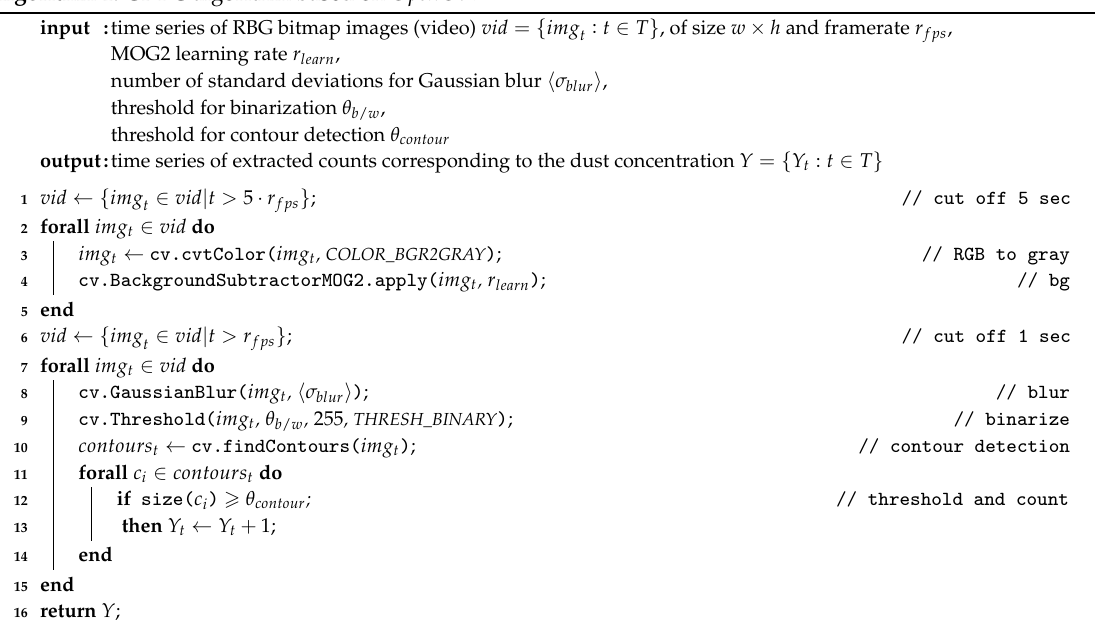
Algorithm 1: CDPC algorithm based on OpenCV .